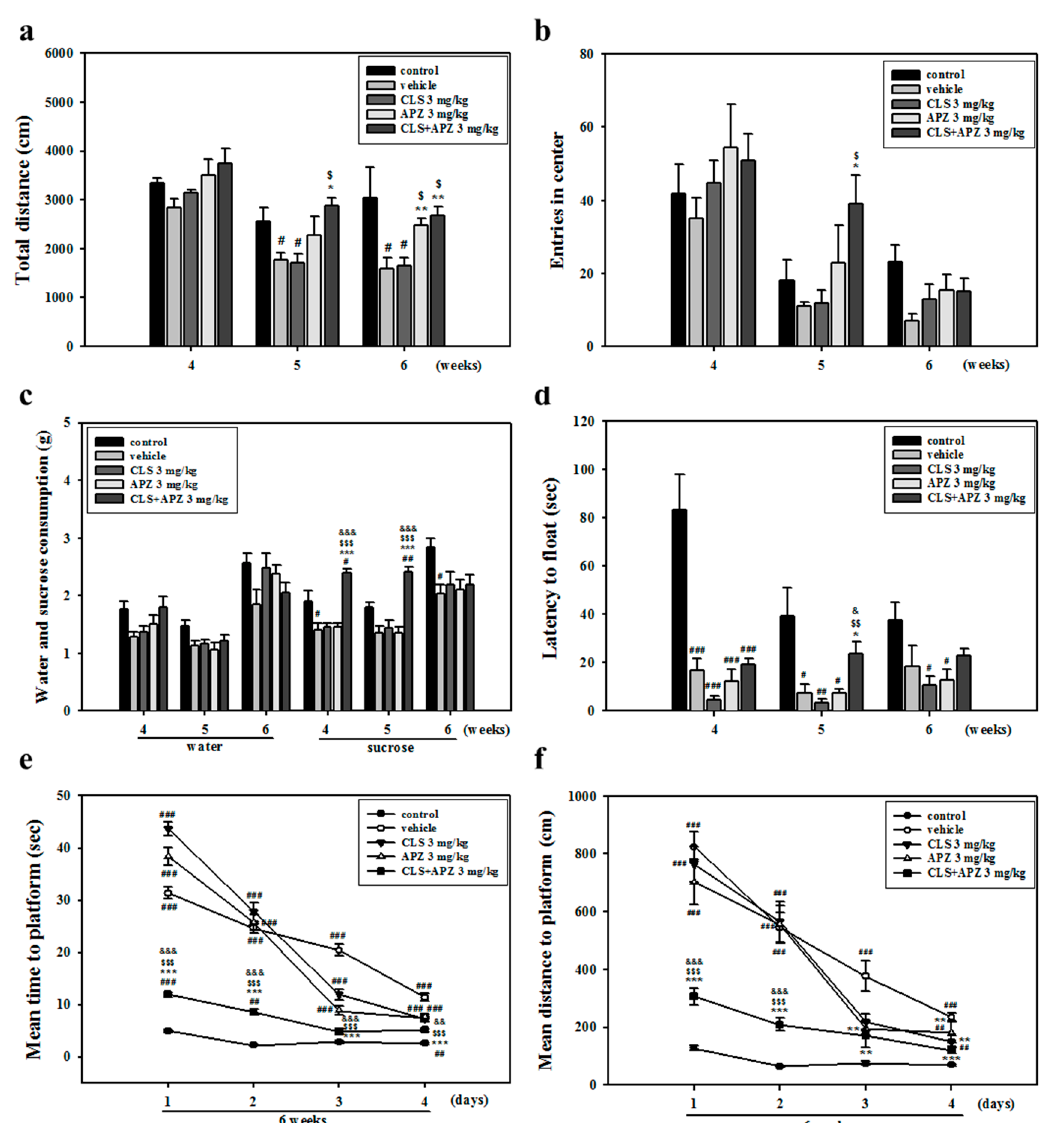
Figure 1. Effect of aripiprazole (APZ) augmentation on depressive behaviors in cilostazol (CLS)-treated mice. Open field ( a , b ) ( n = 6), sucrose preference ( c ) ( n = 5), forced swim ( d ) ( n = 5) and Morris water maze tests ( e , f ) ( n = 6) were performed in CMS-treated mice after ischemic stroke. Combined treatment resulted in significant recovery from depressive behaviors such as anhedonia, despair and impairment of spatial memory. Data are presented as mean ± standard error (SEM). # p < 0.05, ## p < 0.01 and ### p < 0.001 versus control mice; * p < 0.05, ** p < 0.01 and *** p < 0.001 versus vehicle-treated mice; versus APZ-treated